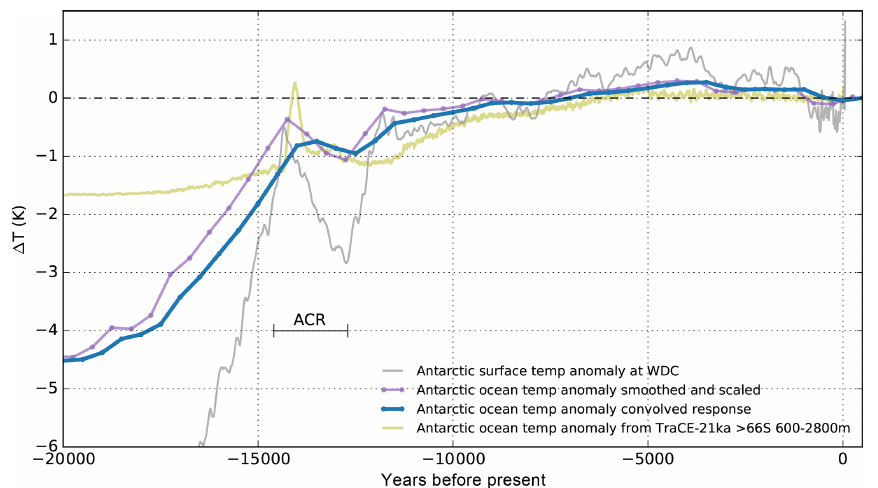
Figure 21. Response of the intermediate ocean temperature (blue) to surface temperature anomaly, as reconstructed from WDC (Cuffey et al., 2016, grey line), assuming a polar amplification factor of 1.8 and an equilibrium ocean scale factor of 0.75, as identified in climate model analysis for a warming scenario. Convolution yields a delayed response (blue) with respect to the forcing, shown here as scaled curve (violet), with dots indicating bins of 500-year means. The time series includes the Antarctic Cold Reversal (ACR) of 14.6–12.7kyrBP (Fogwill et al., 2017). For comparison, GCM ocean temperature anomaly is shown (in olive), as reconstructed by TraCE-21ka (Liu et al., 2009), for the mid-ocean depth 600–2,800m and south of 66 ◦